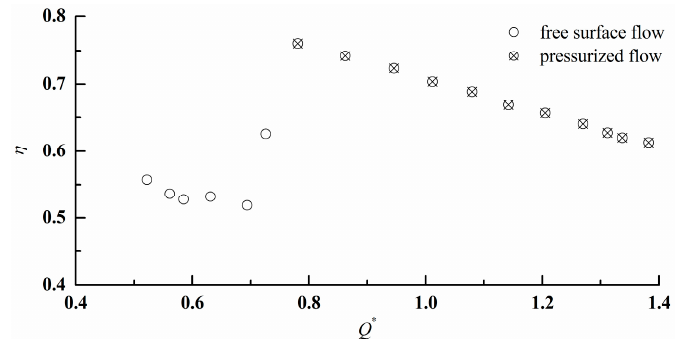
Figure 7. Variation of η with Q* for s = 0.93 m.